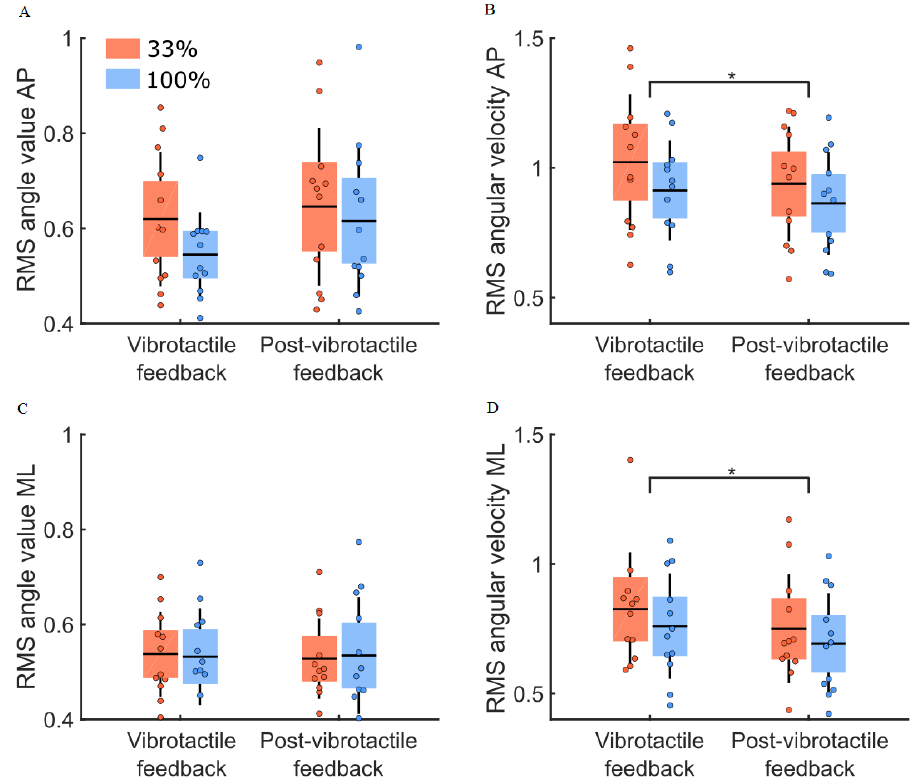
Figure 9. RMS values for body sway angle and angular velocity for both groups (33% and 100% feedback groups, red and blue boxes, respectively) for the vibrotactile (last 10 trials mean) and the post-vibrotactile conditions. Panels ( A , C ) depict RMS values of the body sway angle along the AP